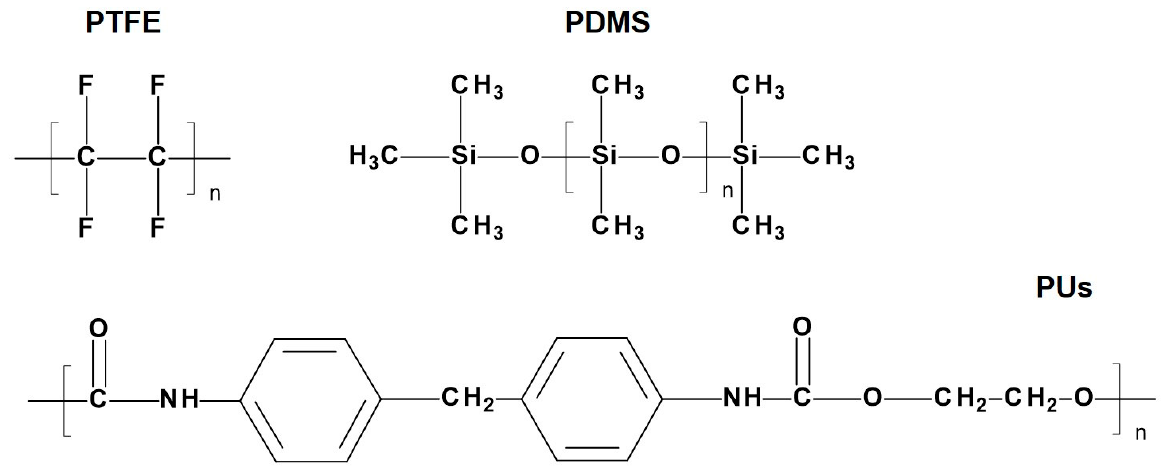
Figure 2. Structural formulas of materials for the first-generation heart valves.